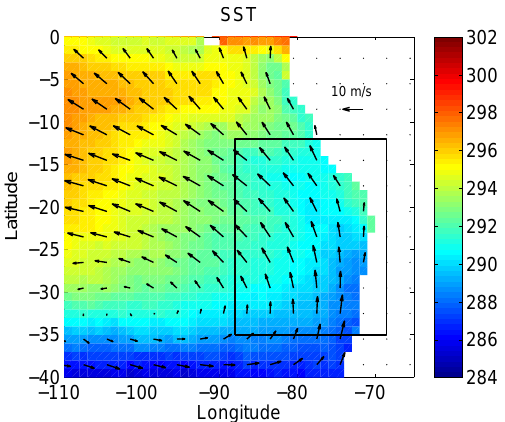
Figure 1. Observed SST (K) from AMSR-E and surface winds from QuikSCAT in the outer VOCA study region during the REx period, 15 October–16 November 2008. The inner study region is shown as a black